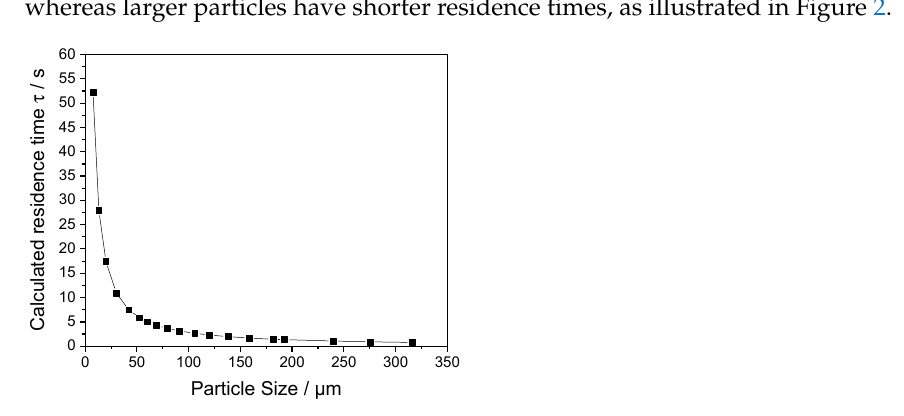
Figure 2. Particle residence time according to the stationary sinking velocity (Equations (1)–(4)) as a function of the particle diameter (reactor length, L R = 0.8 m).